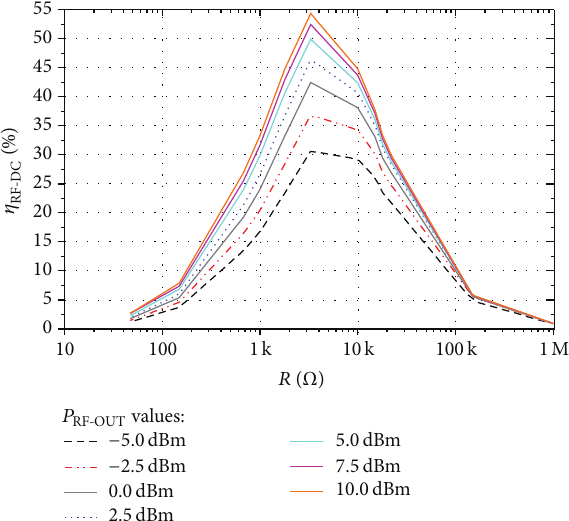
Figure 12: RF-to-DC conversion efficiency of the rectifier as function of the resistive load ( 𝑅 ), for different values of the RF power at the input port of the rectifier ( 𝑃 RF-OUT